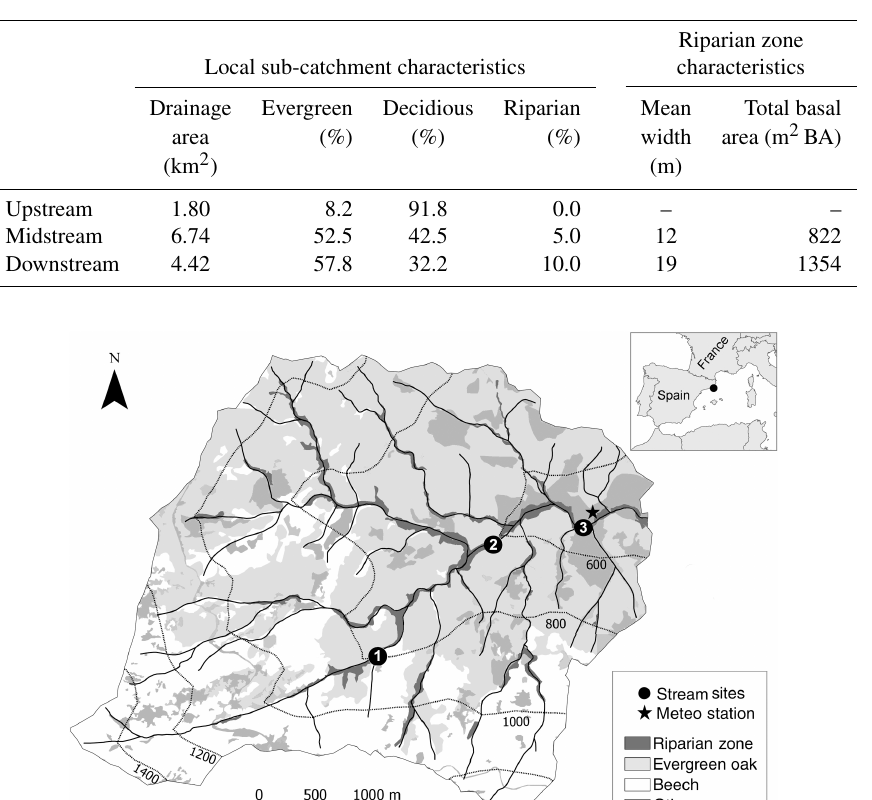
Table 1. Local catchment drainage area, percentage of evergreen oak, decidious beech, and riparian forest area, width of the riparian zone, and total basal area of riparian trees for the three nested catchments considered in this study.